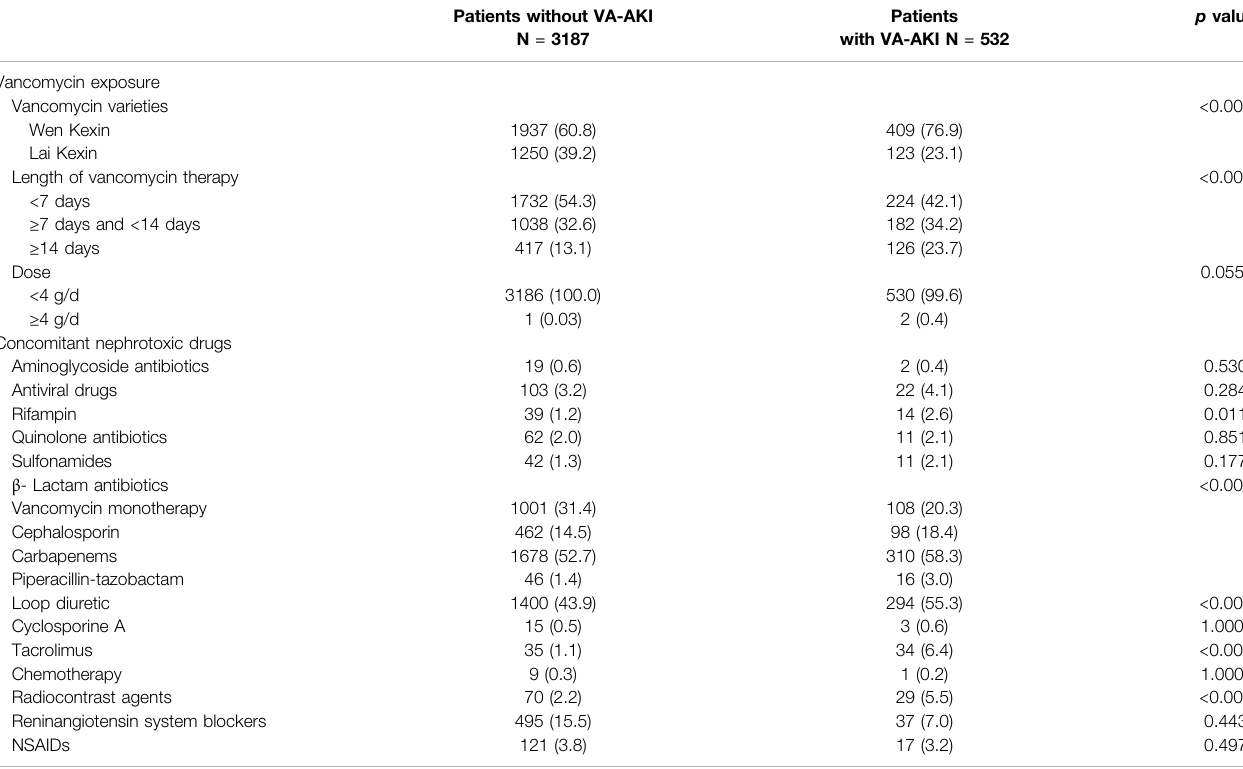
TABLE 2 | Vancomycin exposure and concomitant nephrotoxic drugs of patients with and without VA-AKI.